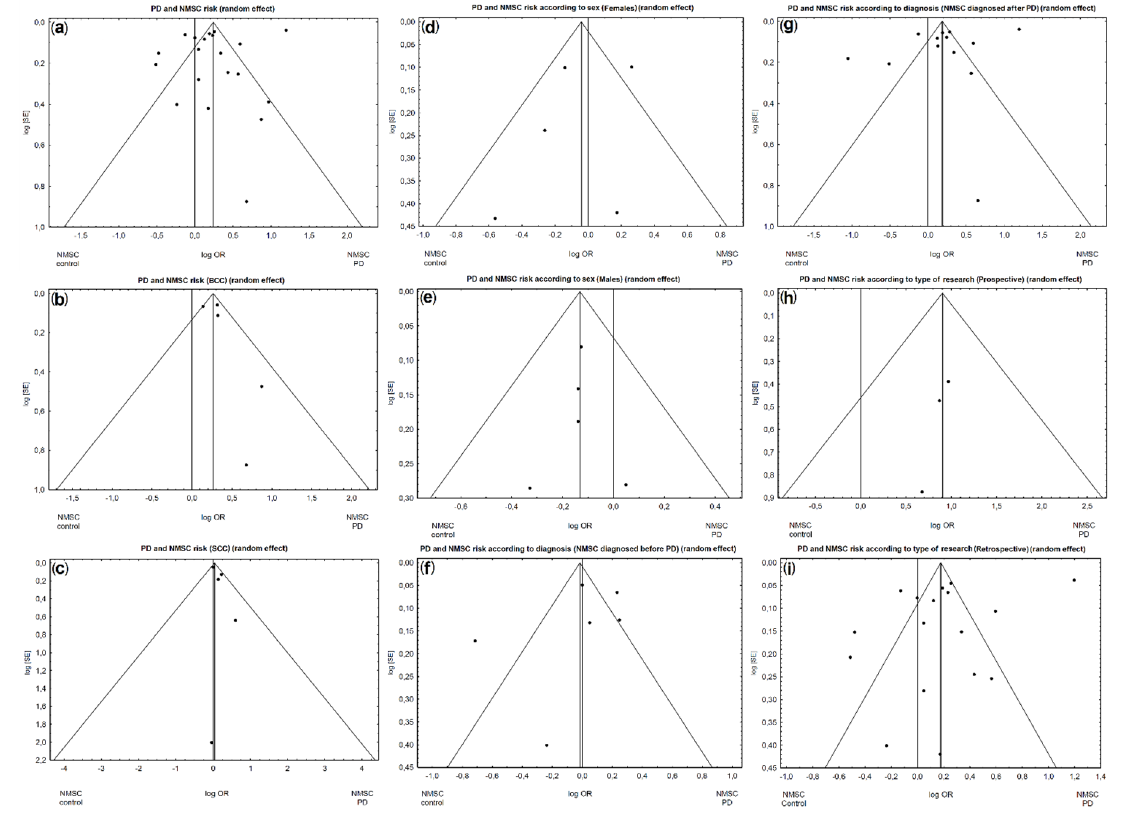
Figure 3. Funnel plot for publication bias in the studies investigating NMSC risk in PD patients: ( a ) all studies; ( b ) BCC; ( c ) squamous cell carcinoma (SCC); ( d ) females; ( e ) males; ( f ) NMSCs diagnosed before PD diagnosis; ( g ) NMSCs diagnosed after PD diagnosis; ( h ) Prospective studies; ( i ) Retrospective studies.